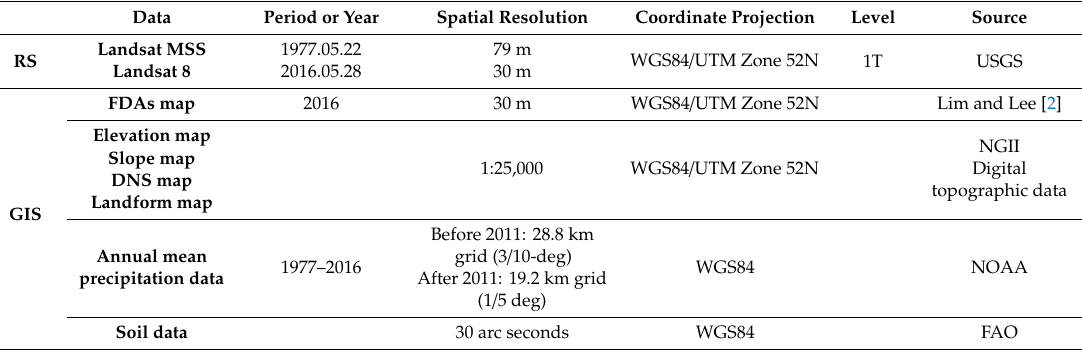
Table 1. Database in this study. DNS: Distance from the Nearest Stream, FAO: Food and Agriculture Organization of the United Nations, GIS: Geographic Information System, MSS: Multispectral Scanner System, NGII: National Geographic Information Institute, RS: Remote Sensing, USGS: United States Geological Survey, UTM: Universal Transverse Mercator, WGS: World Geodetic System.